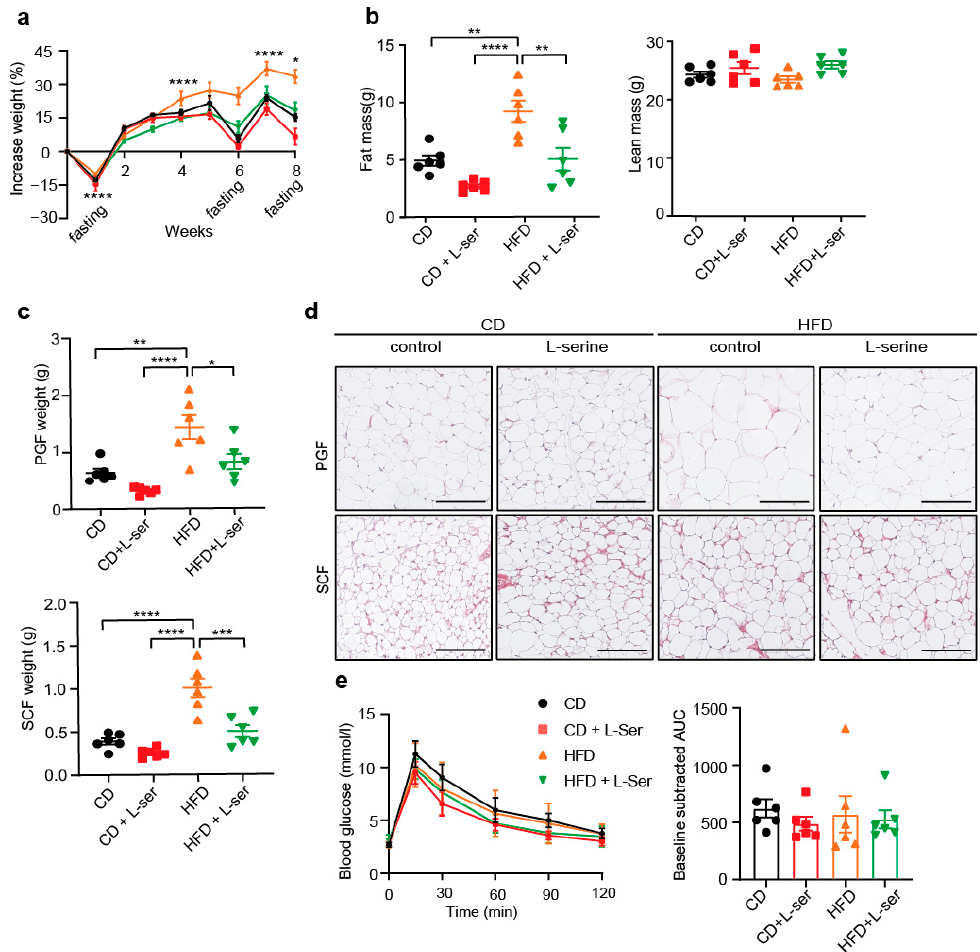
Figure 2. L-serine supplementation blunts fasting-induced body weight regain. ( a ) Body weight increase (%) of mice a fed chow diet (CD) or high-fat diet (HFD) with or without L-serine supple- mentation and repeated overnight fasting for 8 weeks starting at 8 weeks of age ( n = 6). ( b ) Body composition (fat and lean mass) of mice shown in ( a ) after 8 weeks ( n = 6). ( c ) Weight of perigonadal fat (PGF) and subcutaneous fat (SCF) of mice in ( a ) after week 8 ( n = 6). ( d ) Representative H&E stainings of PGF and SCF from mice shown in (a) after 8 weeks. Scale bars show 100 µ M. ( e ) Glucose Tolerance Test (GTT) of CD-fed and HFD-fed mice with and without L-serine supplementation at week 6 ( n = 6). Data are shown as mean ± SEM, one or two-way ANOVA with Tukey’s post-hoc test. * p < 0.05, ** p < 0.01, *** p < 0.001, **** p <